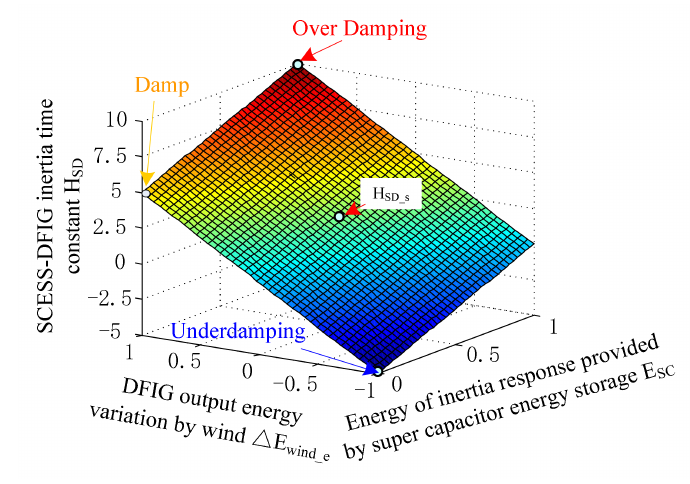
Figure 2. The influence of wind speed on the inertia time constant H SD in